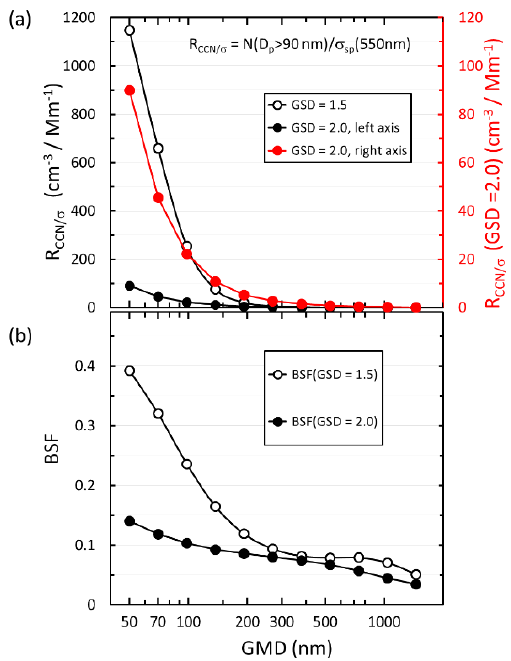
Figure 9. Size distribution of (a) R CCN /σ and (b) backscatter fraction BSF ( λ = 550nm) of simulated narrow (GSD = 1 . 5) and wide (GSD = 2 . 0) unimodal size distributions. GMD: geometric mean diameter; GSD: geometric standard deviation. Note in (a) the R CCN /σ of the wide size distributions is plotted twice: the black symbols and line use the left axis to emphasize the big difference in the magnitudes of the wide and narrow size distributions; the red symbols and line use the right axis to show that the shape of the R CCN /σ size distribution is very similar to that calculated for the narrow size distributions. R CCN /σ was calculated assuming parti- cles larger than 90nm get